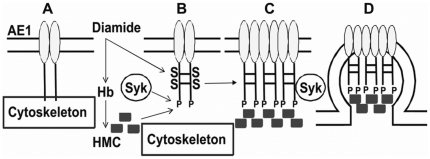
Schematic representation of the proposed mechanism.AE1 is dynamically associated with the cytoskeleton through ankyrin binding in untreated red cells (A). In G6PD deficient RBCs diamide causes irreversible AE1 disulfide cross-linking and its phosphorylation by Syk kinase, diamide also causes progressive hemichrome formation. In control RBCs AE1 oxidation and phosphorylation are transient and no hemichrome formation is observed (B). Hemichromes bind to AE1 and promote the clustering of phosphorylated AE1 (C). Large aggregates of AE1 and hemichromes are released in vesicles (D).